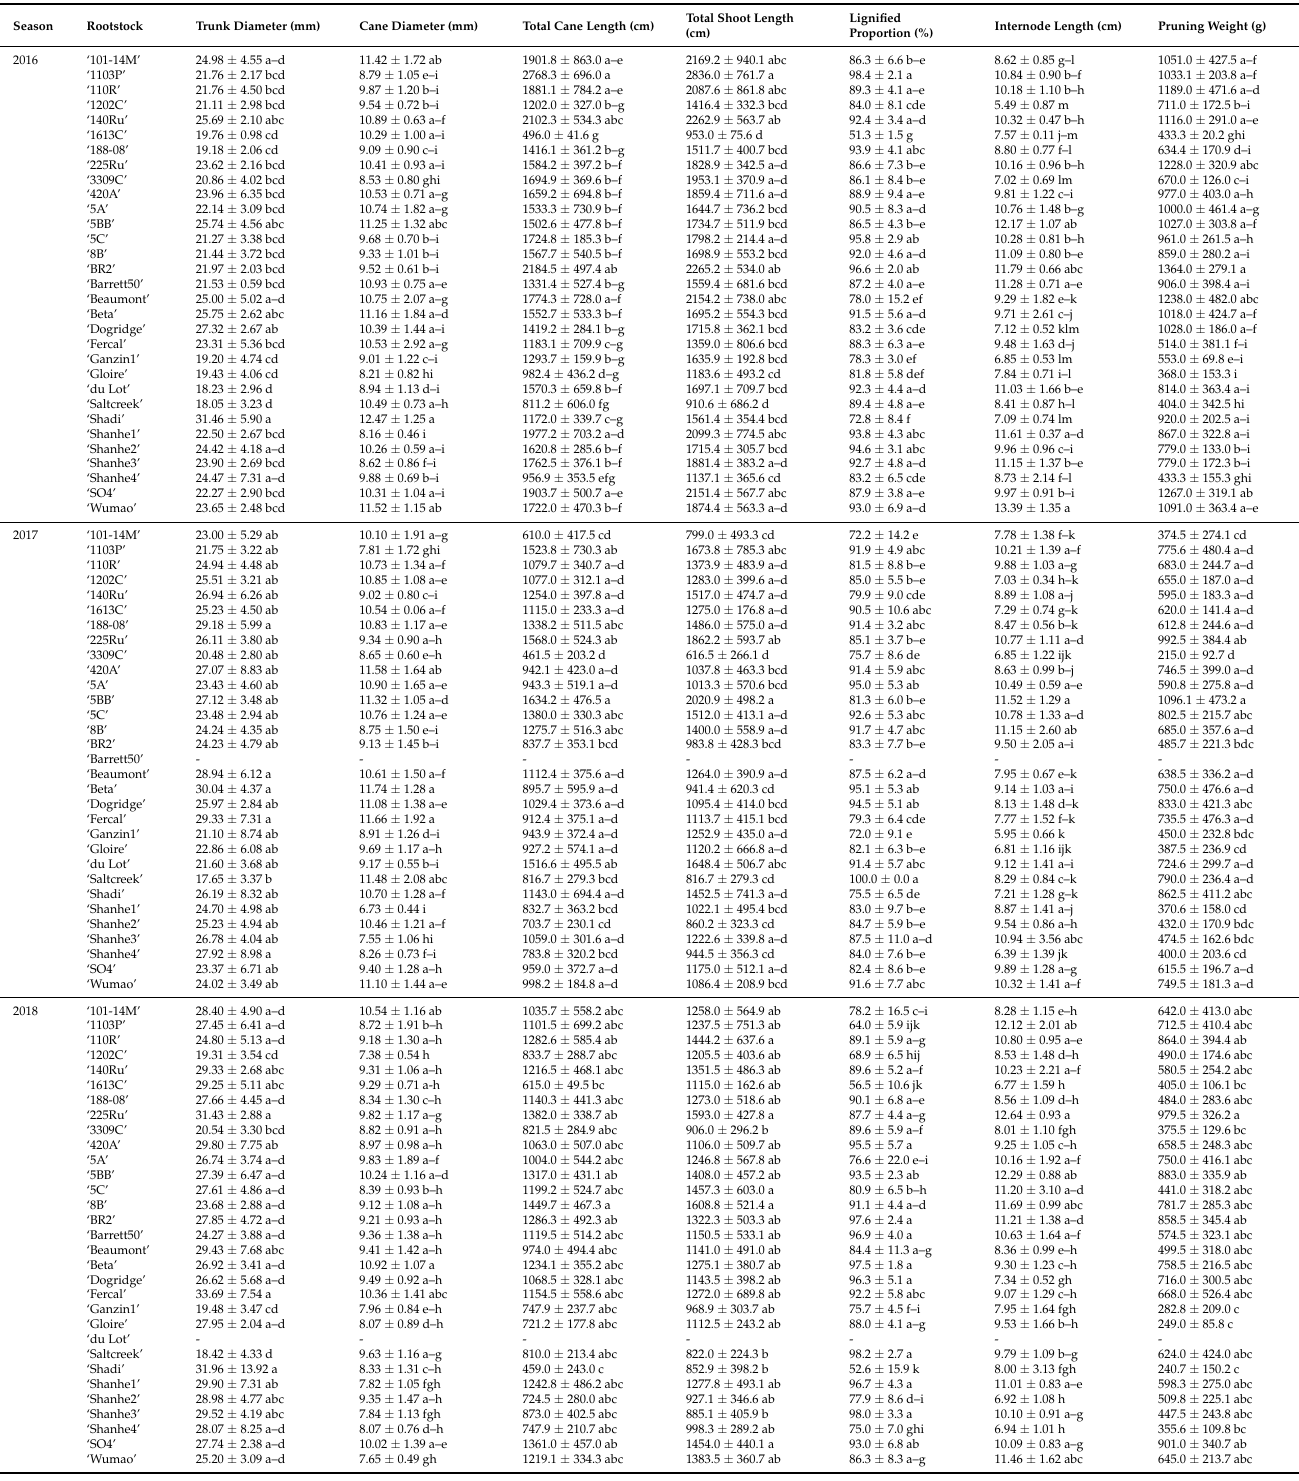
Table 5. Comparison of growth indicators among 31 grapevine rootstocks in three growing seasons (2016–2018) (the adult